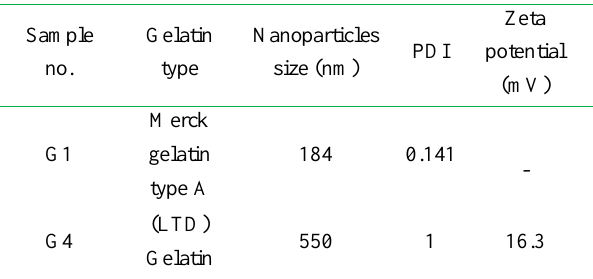
Table 2. Effect of type of gelatin on size and PDI of